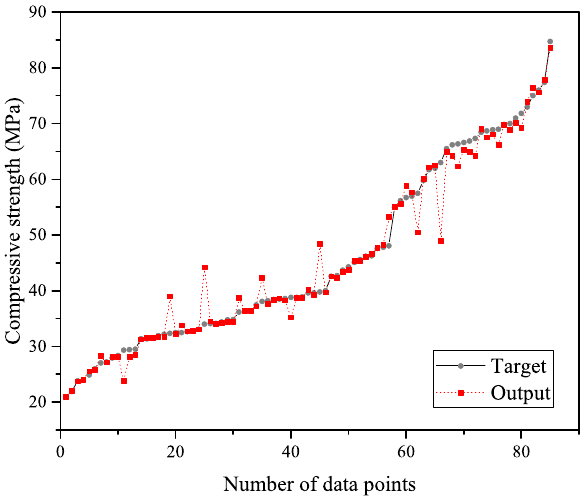
Figure 4. The comparison of the target and output of PFRC. Table 2. MSE, RMSE, MAPE, R coefficient for entire data in the network. Performance of the Output